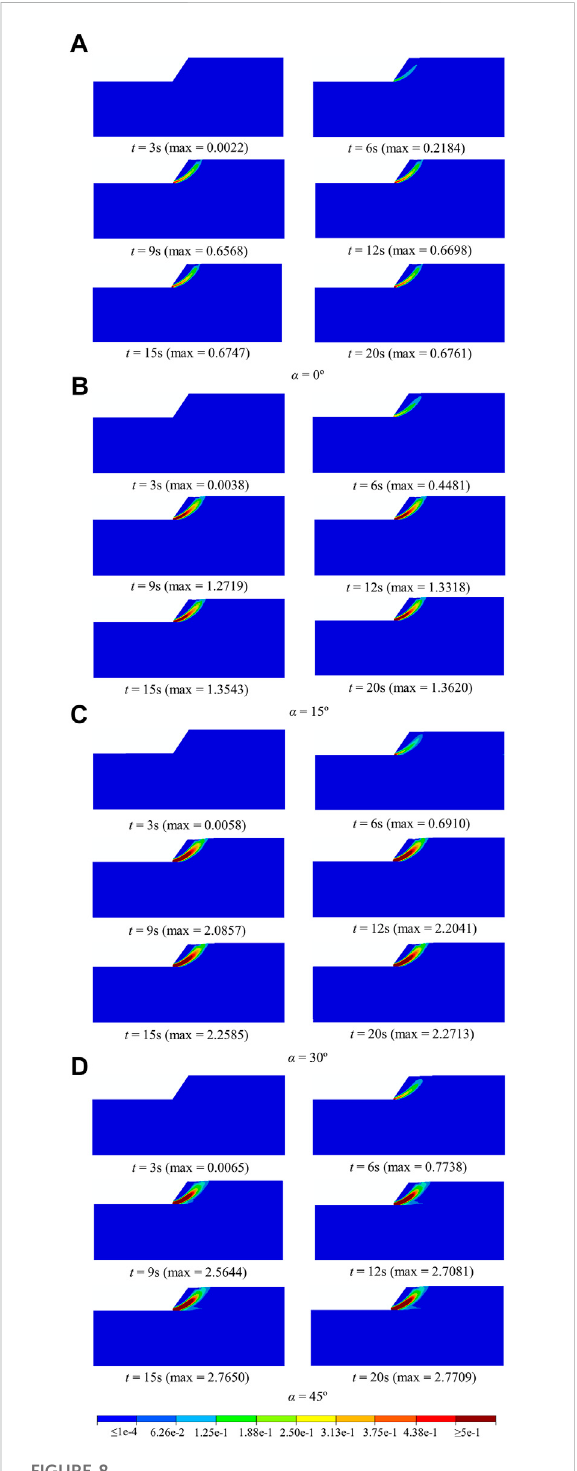
FIGURE 8 Plastic strain nephograms of the slope at different timing with different incident angles. (A) α = 0 ° . (B) α = 15 ° . (C) α = 30 ° . (D) α = 45 °